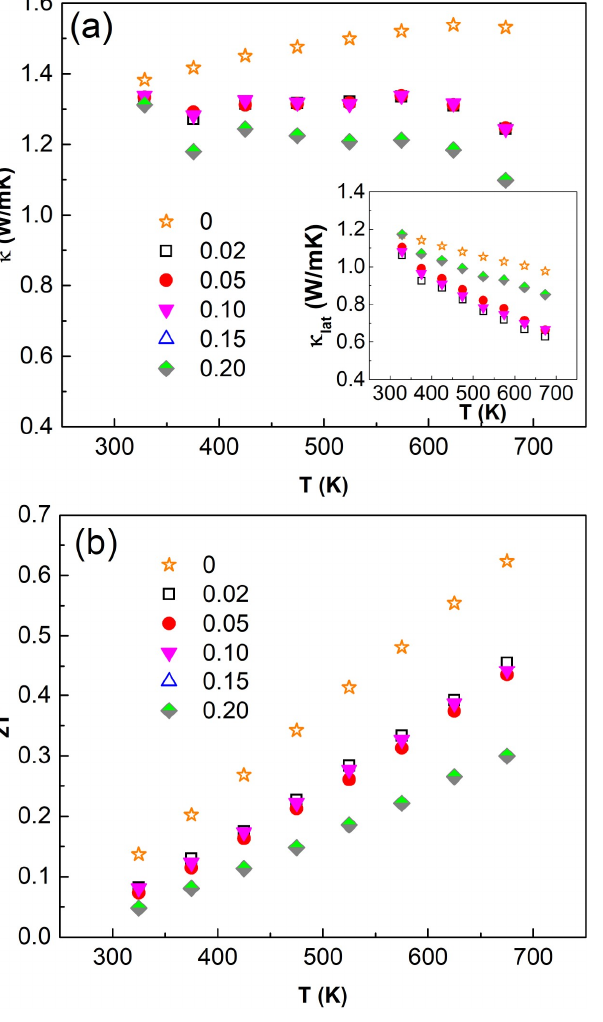
Figure 8. Temperature dependence of ( a ) thermal conductivity, and ( b ) dimensionless figure of merit, ZT of sintered samples as a function of nominal Bi content, X Bi : see Figure. Inset shows the lattice component, κ lat of the total thermal conductivity.